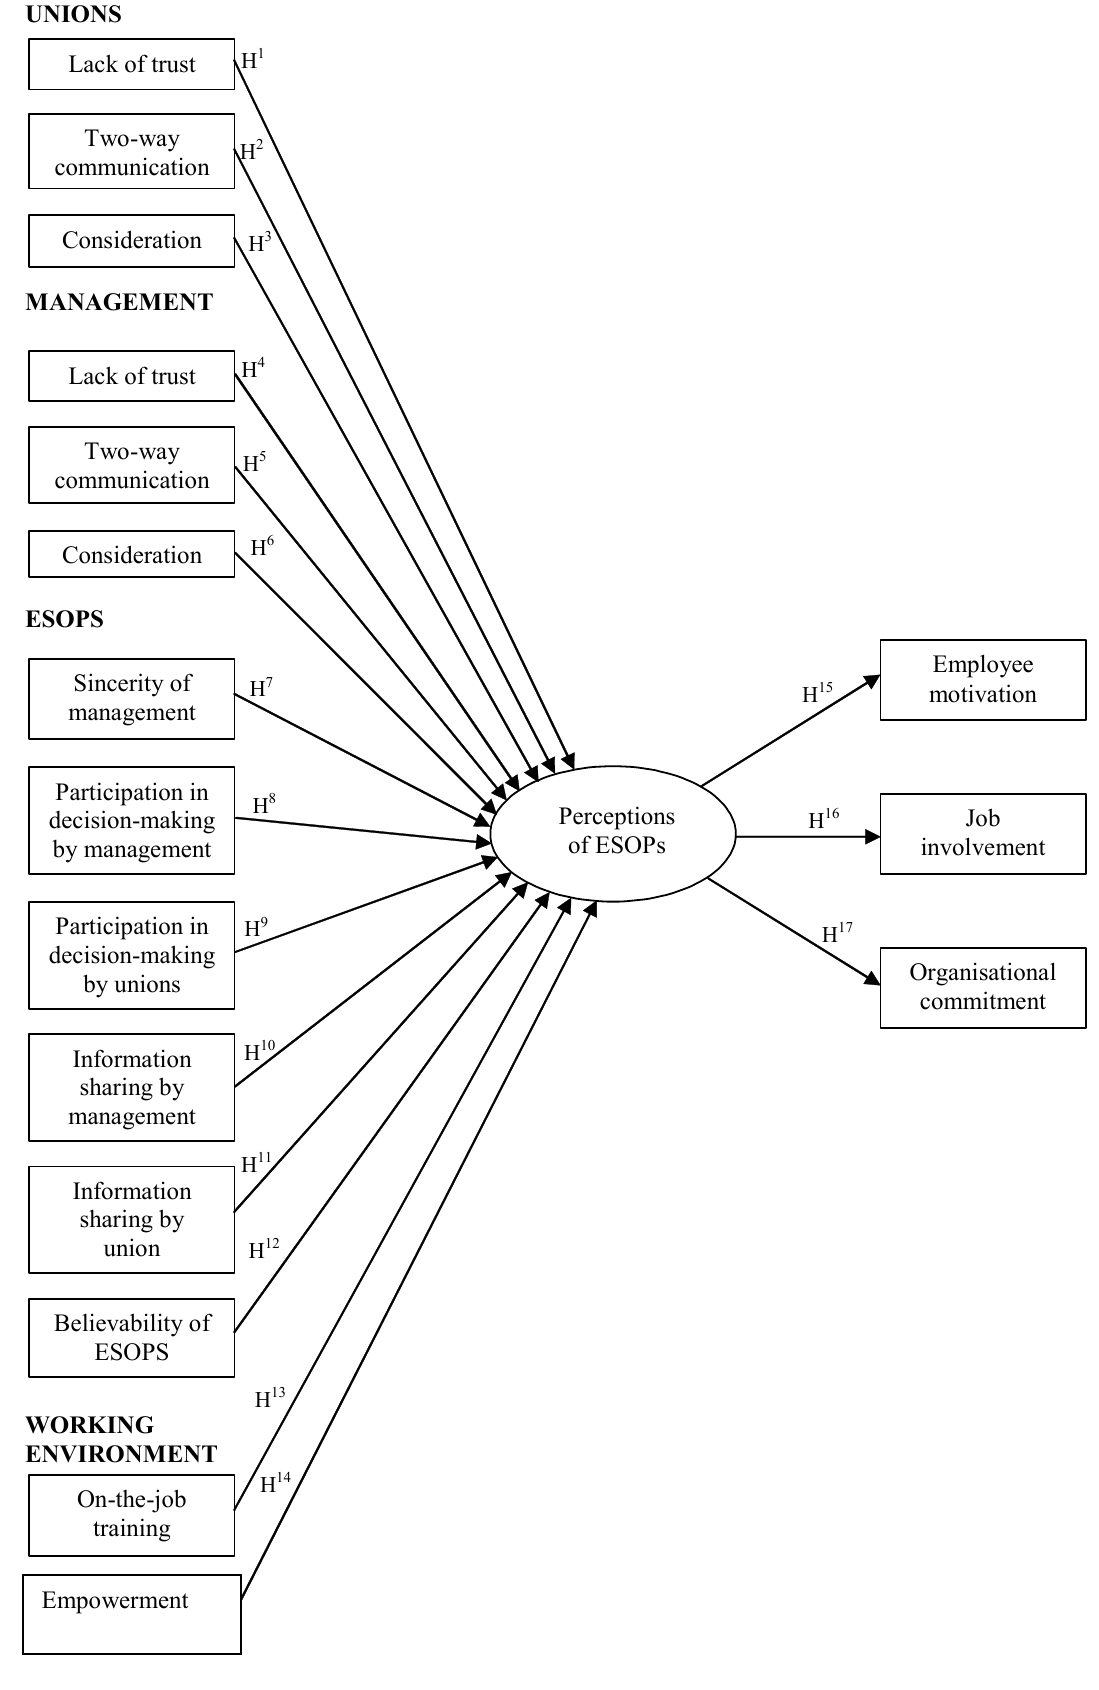
Figure 1: The modelled influences employees’ perceptions and outcomes of employee share ownership schemes